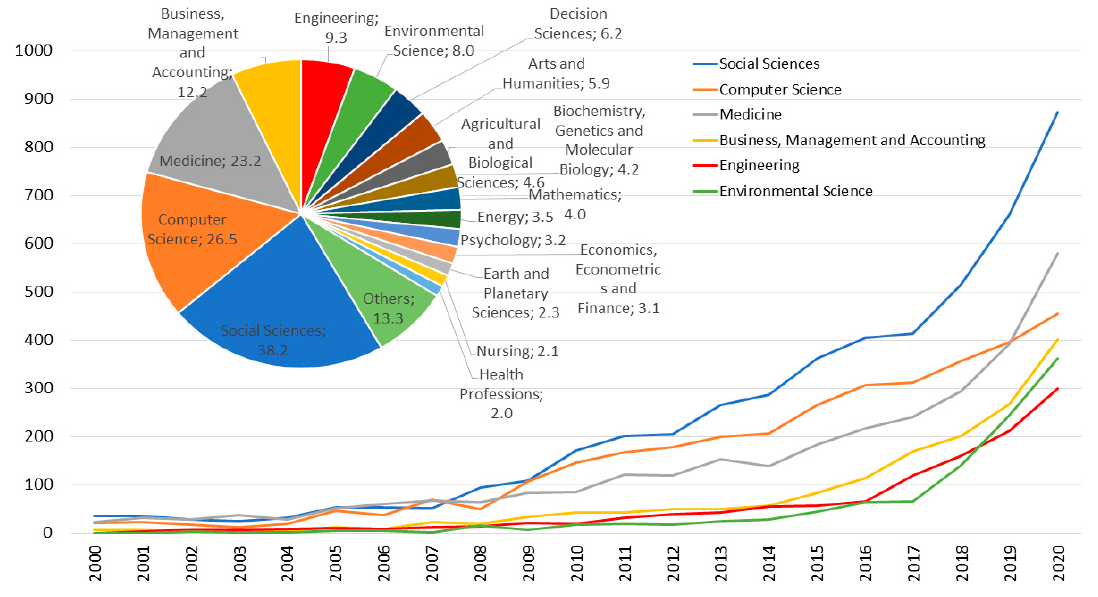
Figure 5. Subject area in Scopus and its trend from 2000 to